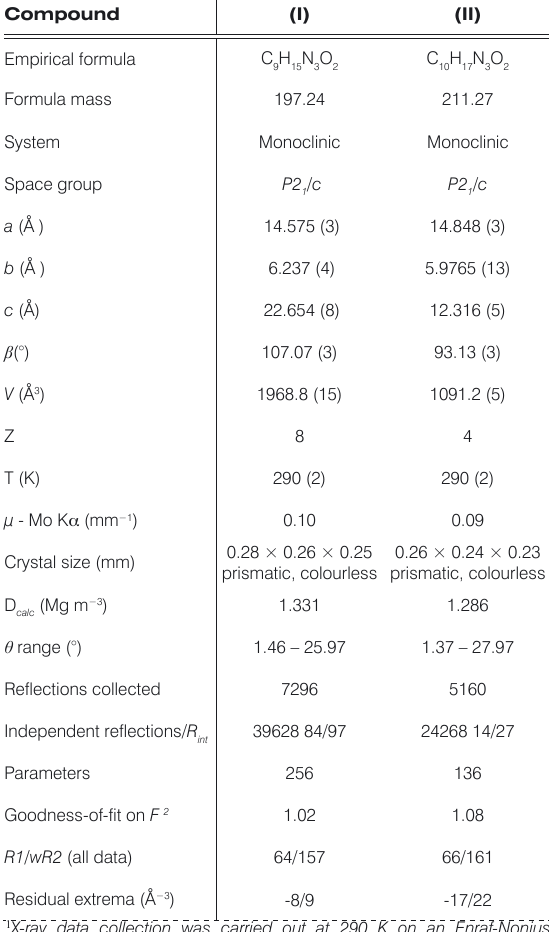
Table 1. Crystallographic data and processing parameters 1